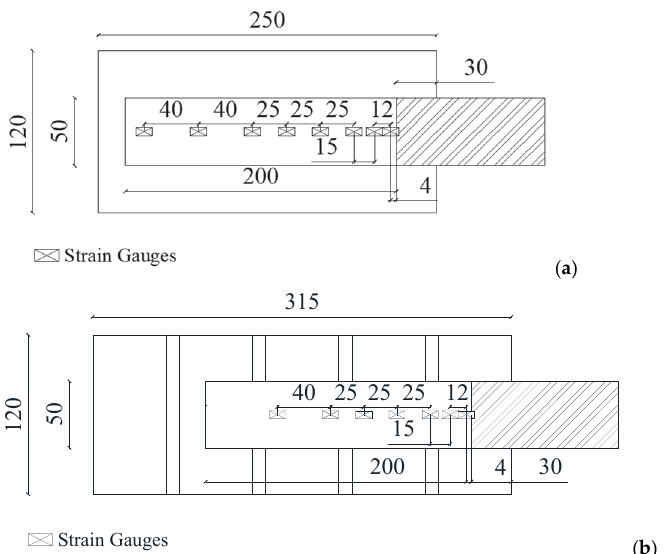
Figure 1. Dimensions of specimens and strain gauge setup: ( a ) setup of clay unit substrate; ( b ) set-up of clay masonry unit substrate.